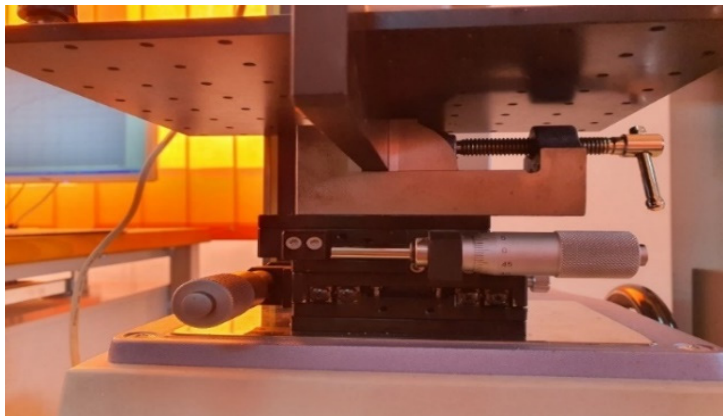
Figure 3. XY table from HV 500 set-up.